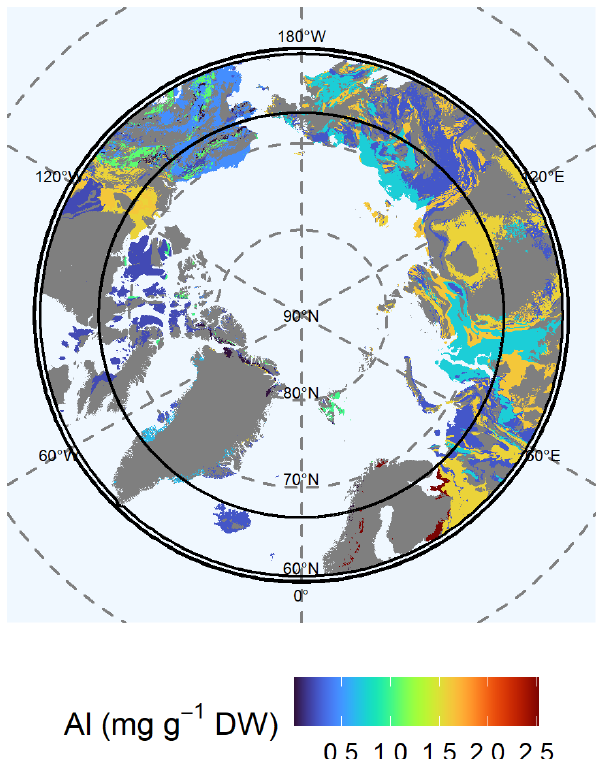
Figure 8. Map of the mean concentration of available (Mehlich-III- extractable) phosphorous (P) for the uppermost 100cm of soils. For each lithological class, the mean concentration is shown. Blue col- ors represent low concentrations of P, whereas red colors represent high concentrations. Gray shaded areas are not represented by our